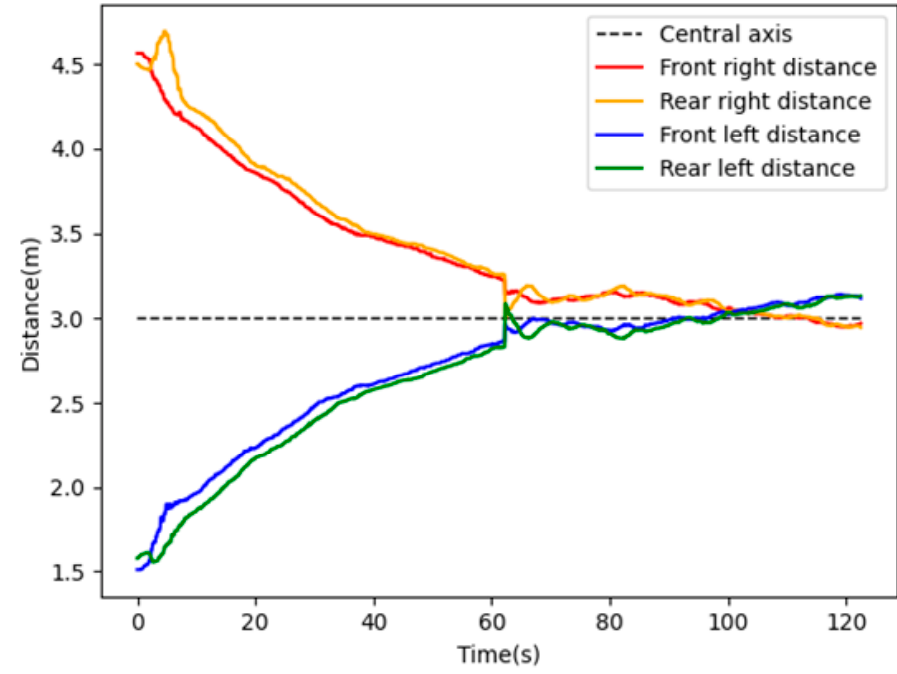
Figure 15. Range value change process of four probes of range sonar.